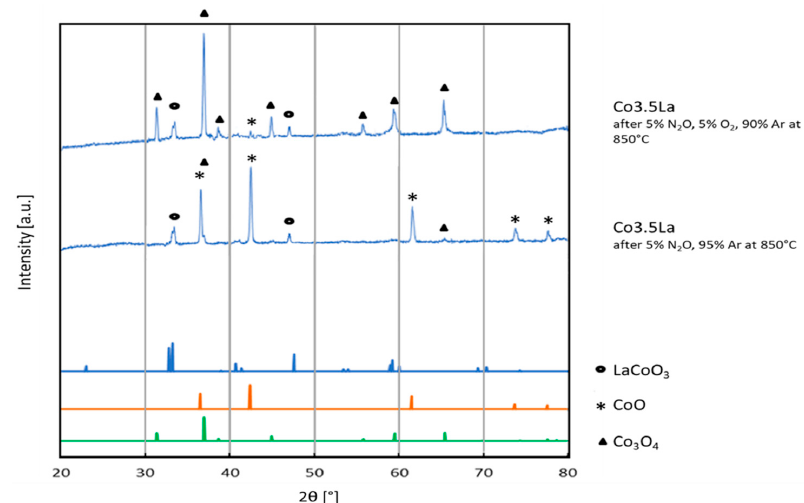
Figure 7. The diffraction patterns of Co3.5La obtained from a sample operating at 850 °C in 5%N 2 O + 95%Ar and in a 5%N 2 O + 5%O 2 + 90%Ar mixture, along with the appropriate reference patterns of Co 3 O 4 (71-0816)—triangles and CoO (48-1719)—stars.